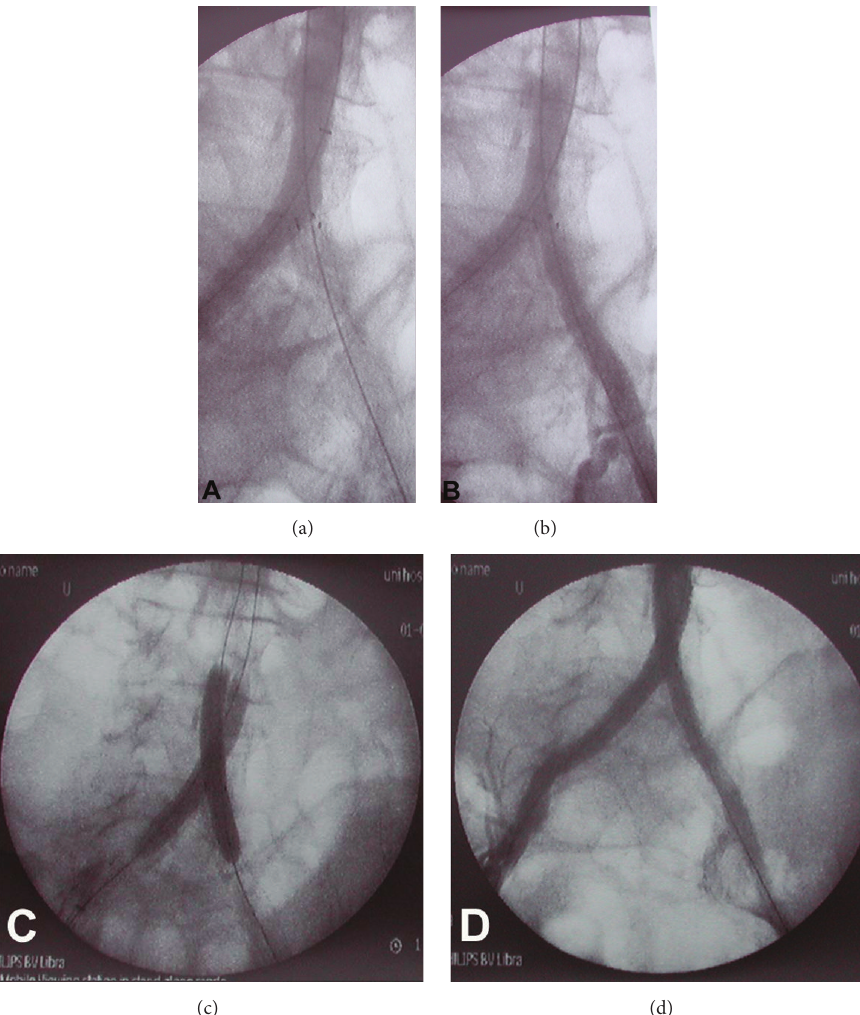
Figure 2: (a) Antegrade angiogram shows obstruction of left iliac artery axis blood flow, from an elevated valve-like calcified intimal flap protruding through the upper pole struts of the left-sided kissing stent. (b) Retrograde contrast injection reduces the obstructing flow flap against the stent wall, demonstrating normal aortoiliac anatomy. (c) Raising the aortic bifurcation with another kissing technique entirely traps the calcified flap between the two stents. (d) Angiogram demonstrating normal aortoiliac blood flow.